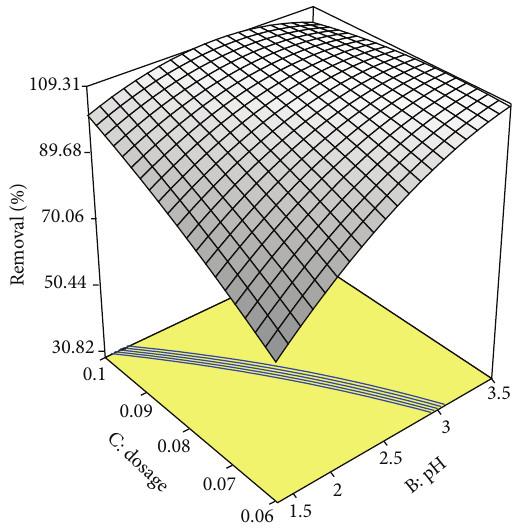
Figure 6: Response surface plot showing the effect of pH and amount of dosage and their mutual effect on the removal of lead using tartrate-Mg-Al layered double hydroxide.